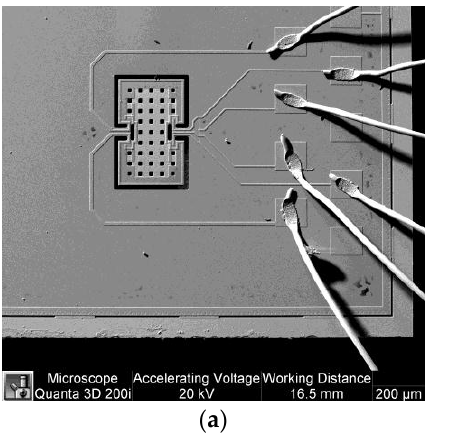
Figure 9. Schematic view of the main components of a MEMS magnetic field device designed by Herrera-May et al. [27]. Reprinted with permission from [27]. Copyright© 2015, Elsevier B.V.